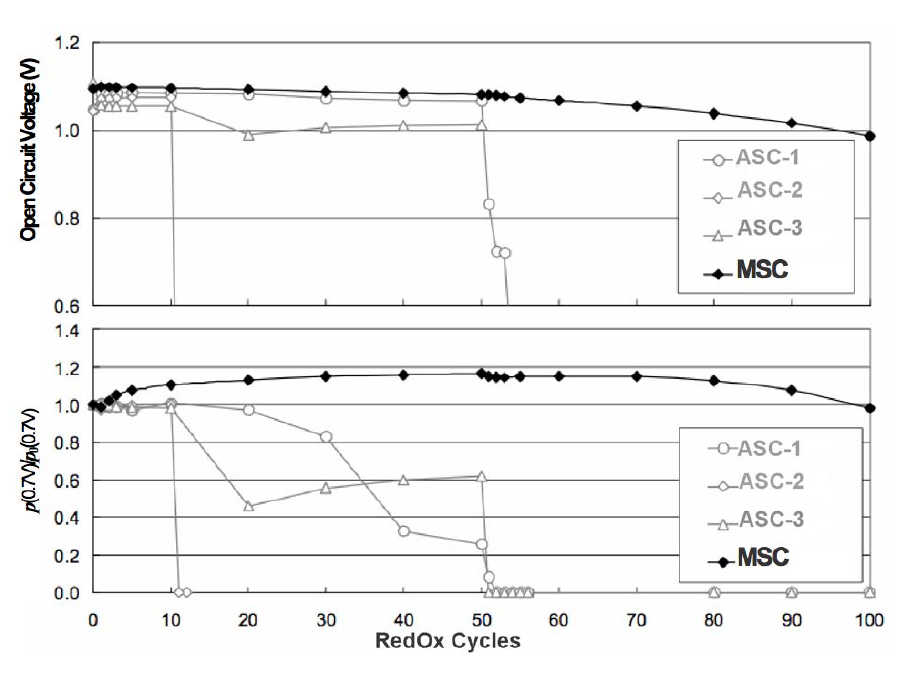
Figure 23. RedOx stability of anode supported cells (ASCs) (with support thickness of 1, 0.4 and 0.5 mm for ASC-1 (from Forschungszentrum Jülich), ASC-2 and ASC-2, respectively [14]) compared to metal supported cell (MSC), under 50 RedOx cycles of 1 min and 50 RedOx cycles of 10 min at 800 °C. Top: open circuit voltage, bottom: normalized performance at 0.7 V